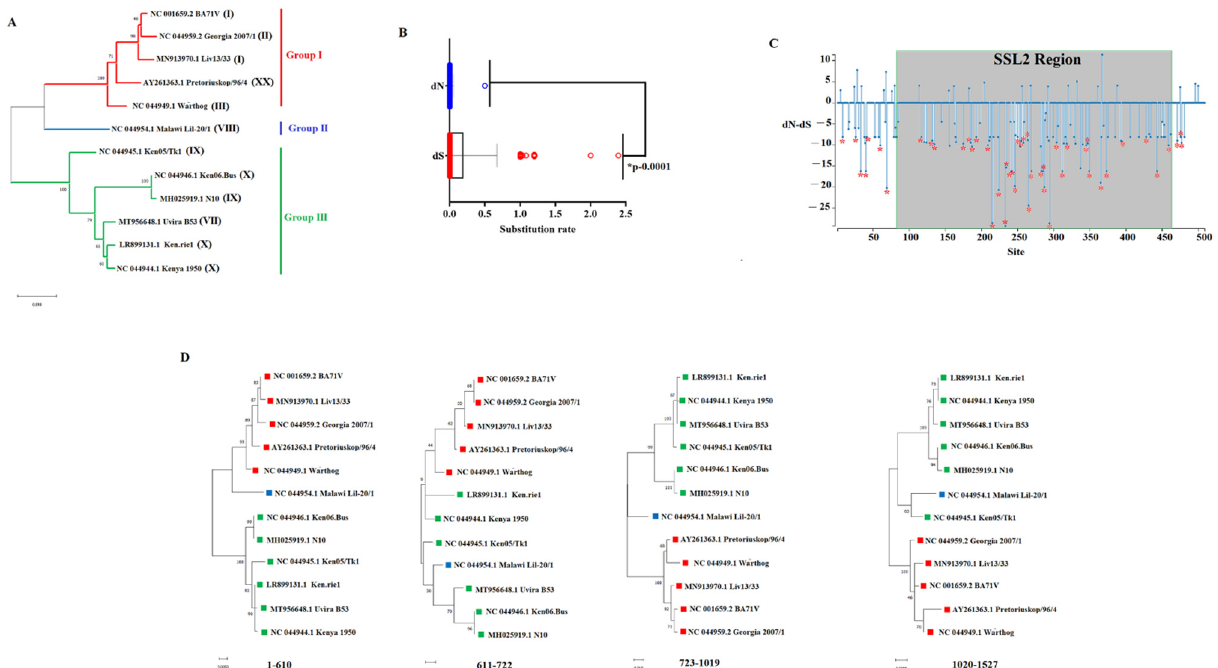
Figure 2. Evolutionary dynamics of the QP509L gene. ( A ) Phylogenetic analysis conducted by the maximum likelihood method, showing the diversity of the QP509L gene of ASFV in the field. Based on the cluster distribution, isolates were classified into three main groups (I, II, III). Numbers in the parentheses show the genetic lineage classification of different ASFV isolates based on the p72 classification. Numbers above internal branches represent bootstrap values (1000 repetitions). Phylogenetic analysis was conducted using the software MEGA 10.2.5. ( B ) Comparison between synonymous (dS) and nonsynonymous (dN) substitutions rates during the evolution of the QP509L gene. Significant differences between means at dS and dN were determined by the unpaired t -test. ( C ) Graphic representation of the ratio dN–dS at specific codon sites in the QP509L gene of ASFV. The region highlighted in grey represents the location of the functional region SSL2, while red asterisks represent codon sites evolving under purifying selection. Specific sites under purifying selection at the SSL2 region include: 117, 132, 135, 175, 185, 187, 193, 209, 215, 224, 233, 234, 241, 242, 246, 250, 255, 258, 264, 265, 269, 283, 285, 287, 294, 304, 312, 318, 345, 347, 349, 365, 373, 394, 428, 443, and 459. Analysis was conducted using the evolutionary algorithms FEL considering a cutoff value of p = 0.1. ( D ) Phylogenetic analyses showing topology incongruences among different segments where distinct breakpoints were inferred by GARD on the QP509L gene. Squares of different colors represent phylogenetic groups identified in Figure 2A. Numbers above internal branches represent bootstrap values (1000 repetitions). Phylogenetic analysis was conducted as described in Figure